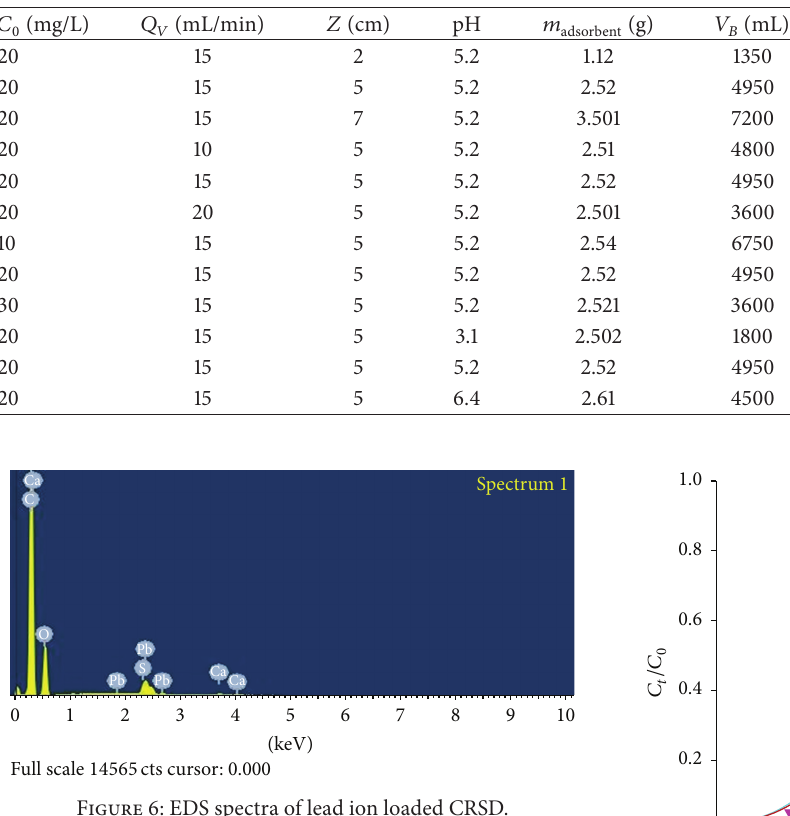
Table 3: Parameters in fixed-bed column for lead adsorption by CRSD.